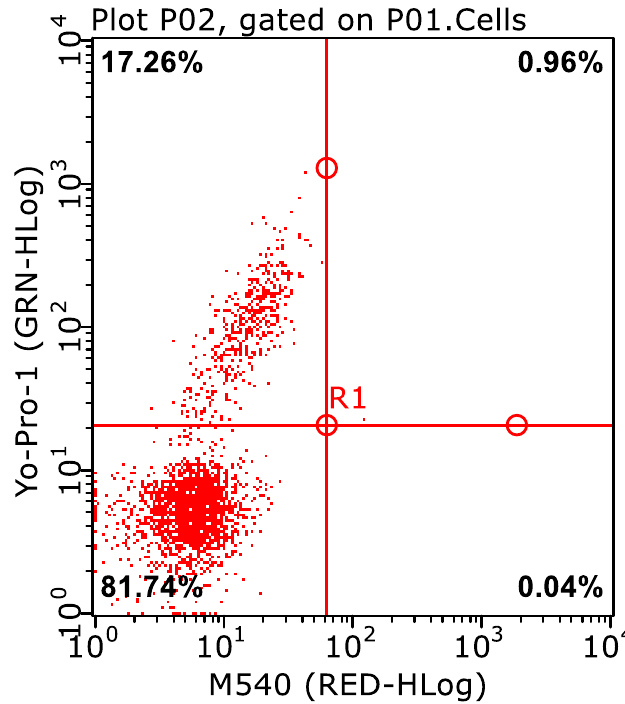
Figure 7. An example of a dot plot with live spermatozoa without destabilized membranes in the Control group in the lower left quadrant (81.74%): Mer-/Yo-Pro-1- (Merocyanine 540 (M-540) assessing capacitation-related membrane destabilization; YO-PRO-1 assay for apoptosis evaluation).